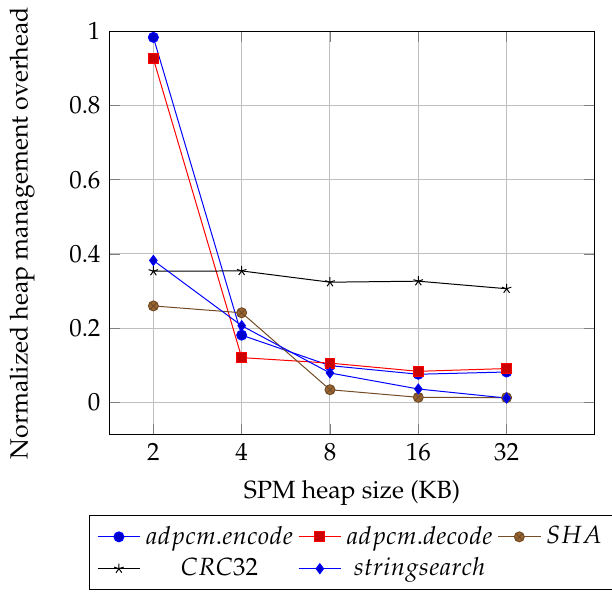
Figure 16. Enc/Dec time in heap normalized by total execution time.